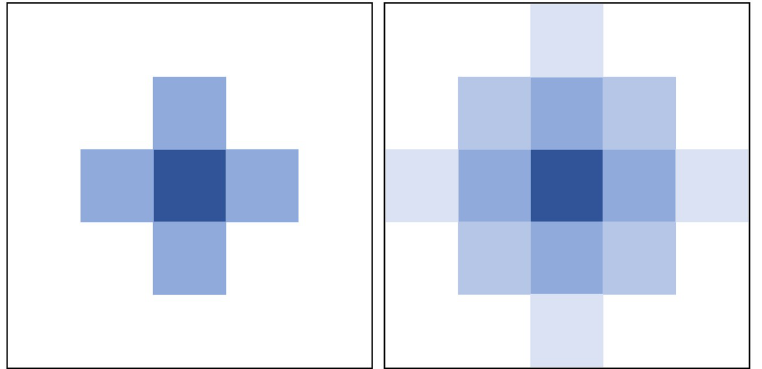
Fig 3. The dispersion spot generated by multiple scattering. Due to the influence of multiple scattering, the original clear image will be blurred, and the dispersion spot will be formed in local area.